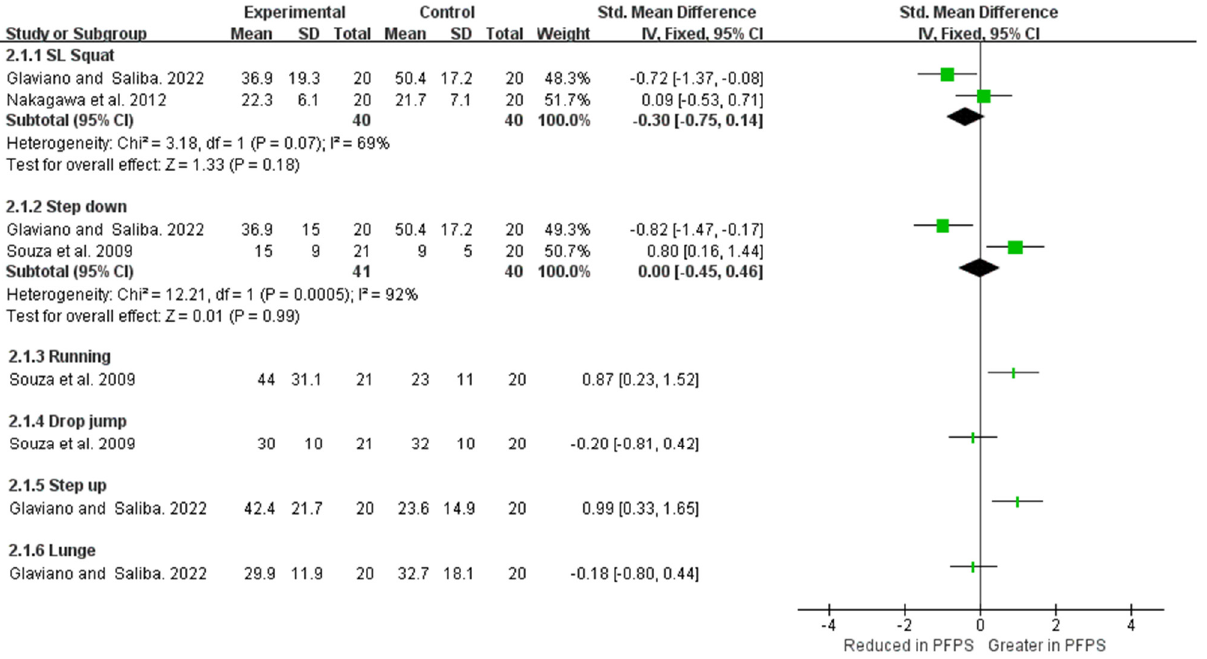
Figure 11. GMax activation between PFPS and control group among the various functional activi-